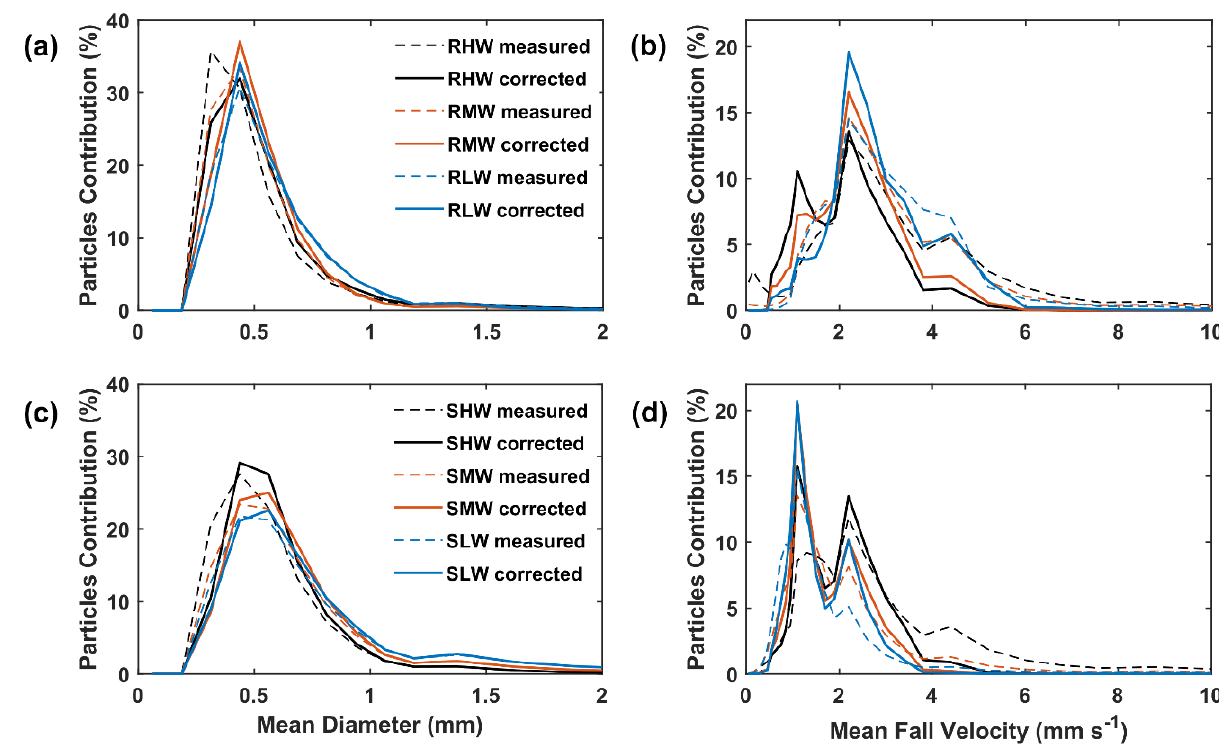
Figure 7. Mean particles’ contribution per diameter and per fall velocity for liquid ( a , b ) and solid precipitation groups ( c , d ). The percentages were derived from the total particles of each DSD before being averaged. Dashed line refers to measured DSDs, while continuous line refers to the corrected DSDs.